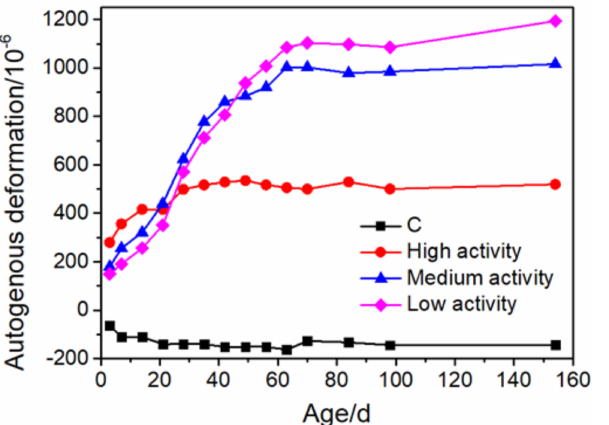
Figure 1. The influence of MgO reactivity on autogenous deformation of mortar (adapted from Ref. [23], 2019, Elsevier).